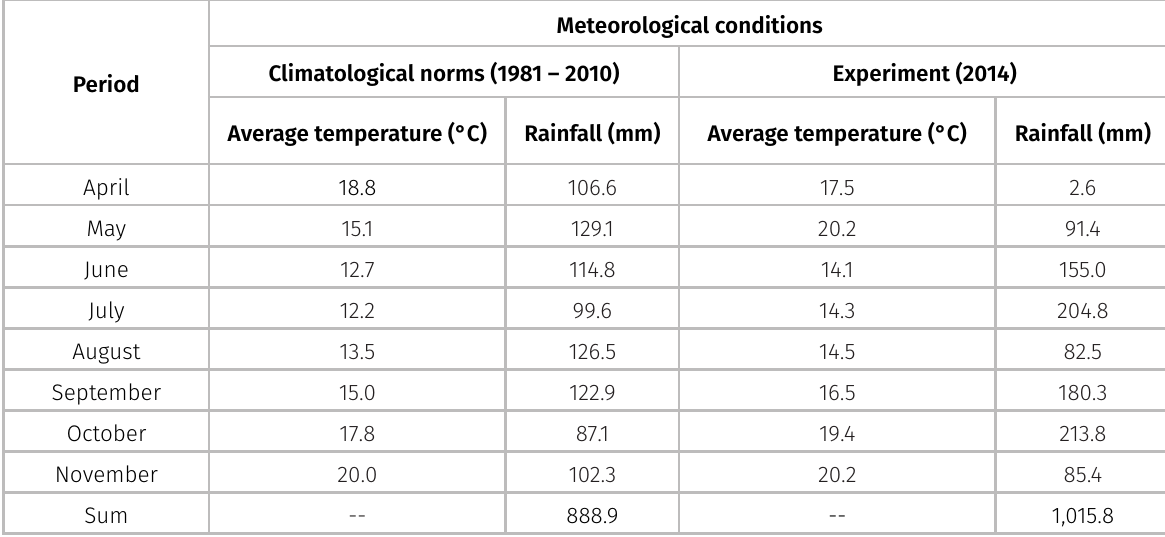
Table I. Climatological norms between 1981 and 2010 for Pelotas, Rio Grande do Sul, Brazil, and meteorological conditions between sowing and the end of the experimental